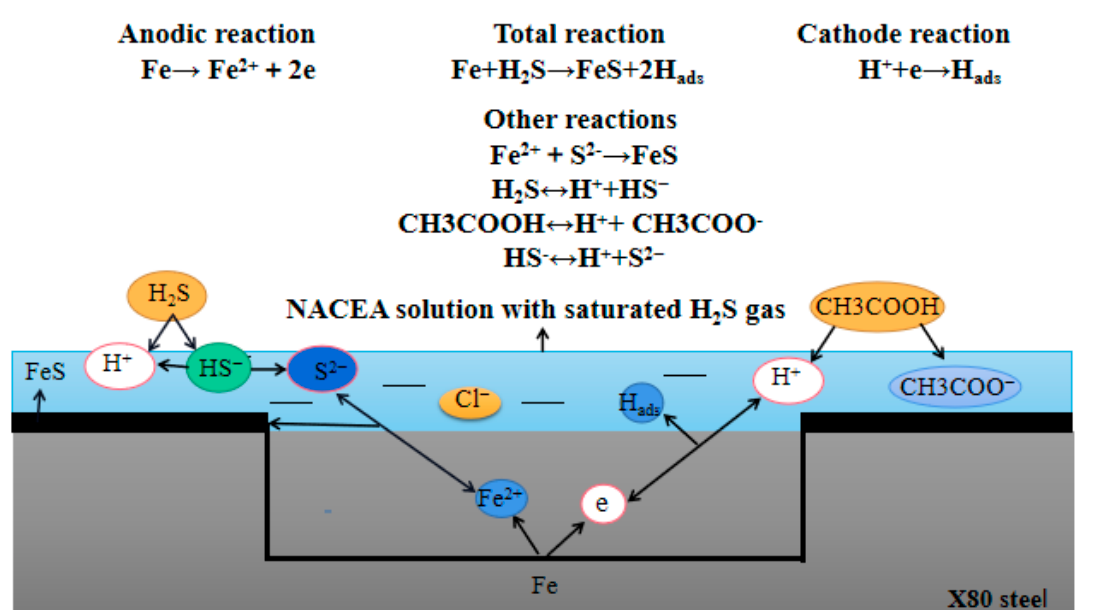
Figure 17. Schematic of the formation process of sulfide film on X80 pipeline steel surface after immersion in NACEA solution with saturated H 2 S gas at 50 °C.